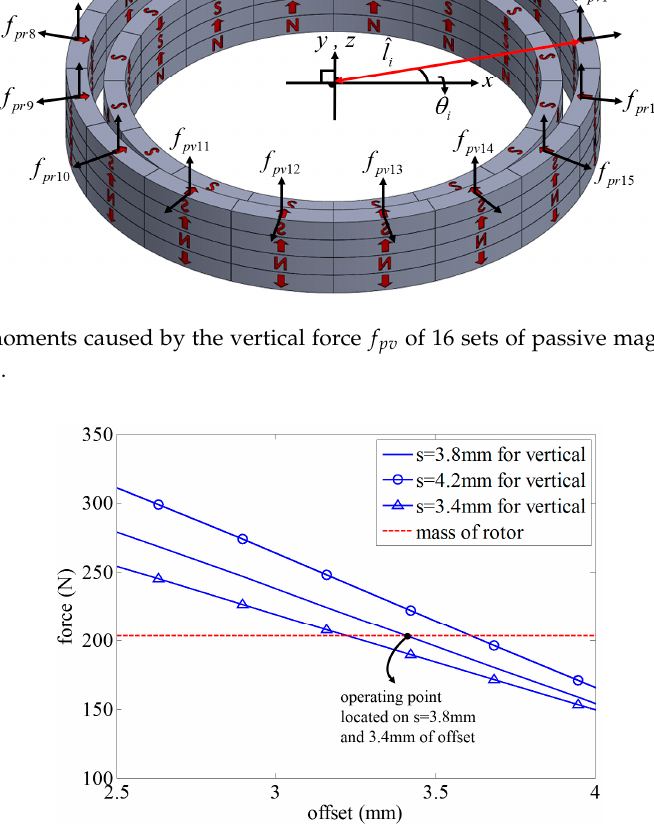
Figure 11. The resulting magnetic forces of PMB on vertical direction.